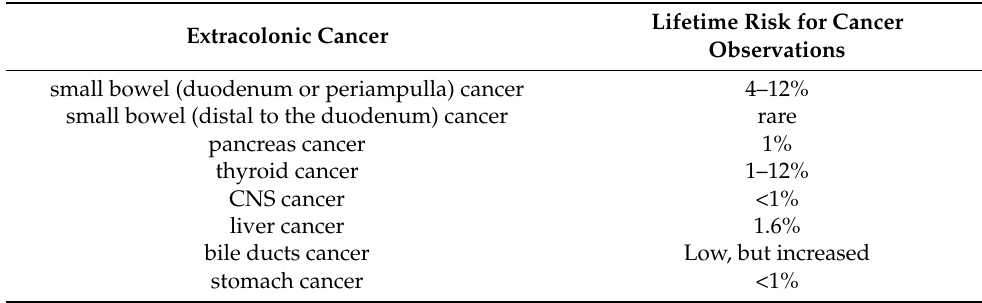
Table 1. Extracolonic cancer in FAP—lifetime risk (modified after Jasperson ) [21]. Extracolonic